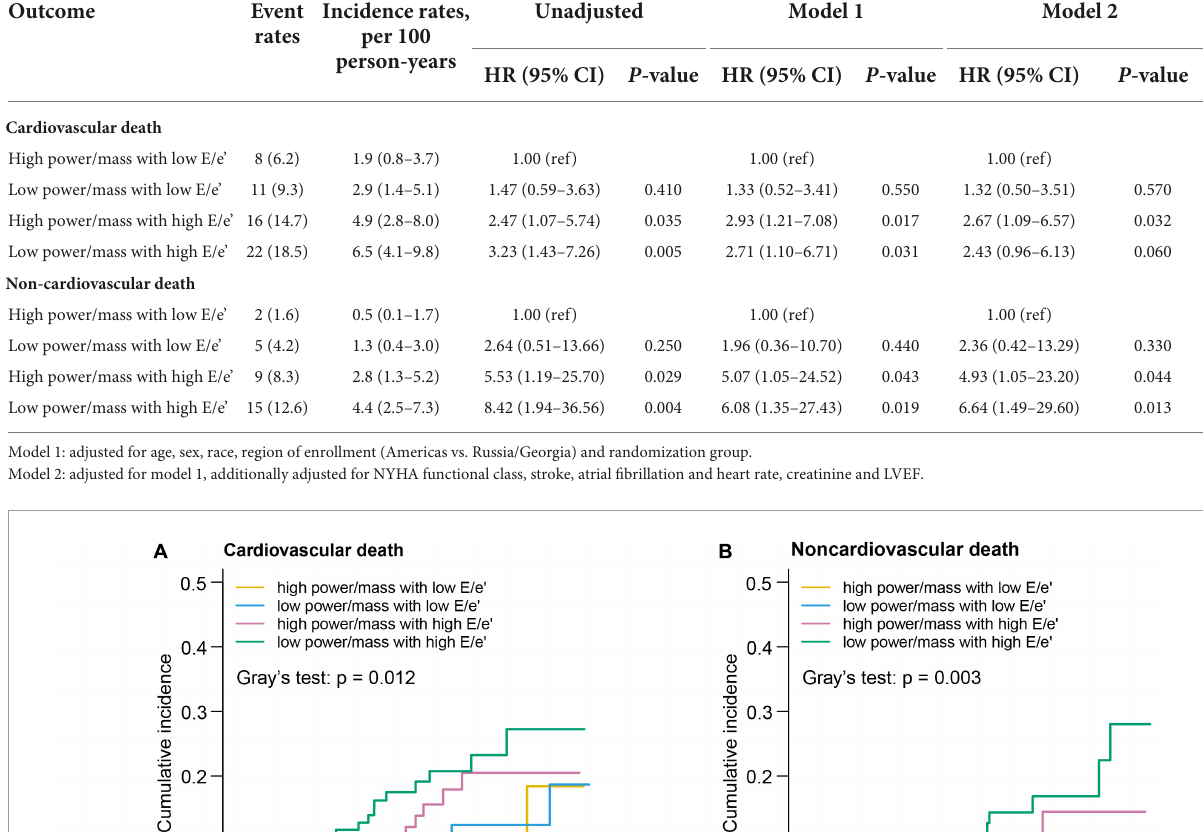
TABLE 3 Risk of cardiovascular and non-cardiovascular death in HFpEF patients by power/mass and E/e’ ratio categories. Outcome Event Incidence rates, rates per 100 person-years